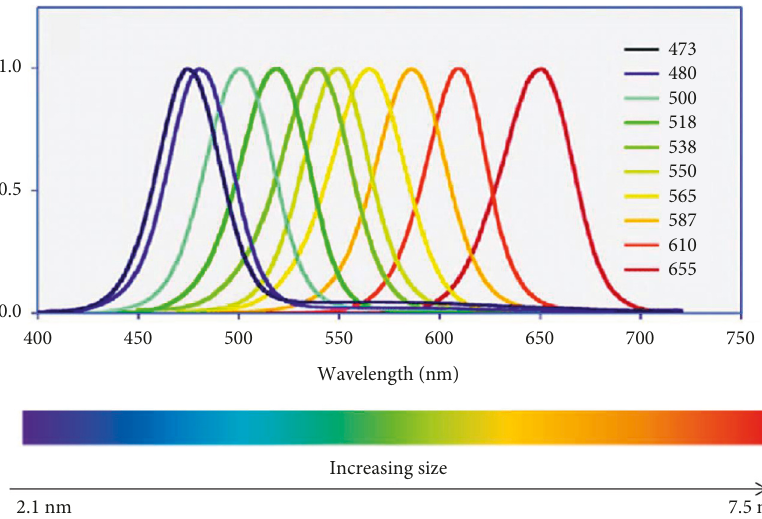
Figure 2: Size-tunable photoluminescence spectra of quantum dots (adapted from